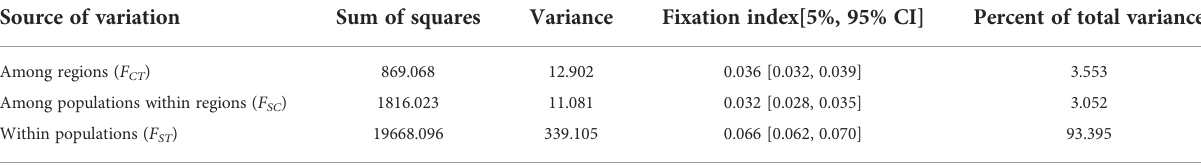
TABLE 3 Partitioning of genetic variance from six saltcedar populations using AMOVA. Source of variation Sum of squares Variance Fixation index[5%, 95% CI] Percent of total variance Among regions ( F CT )